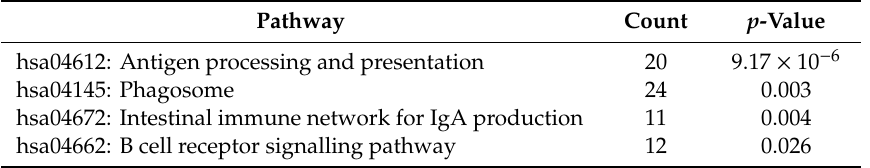
Table 1. KEGG pathway analysis of PVL versus control white matter transcriptomic datasets. Pathway